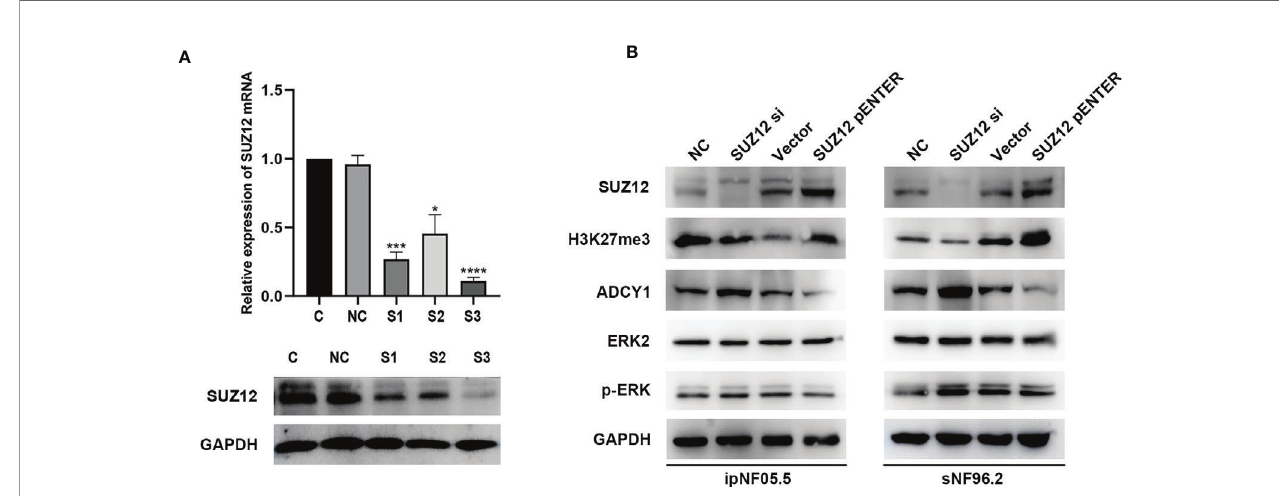
FIGURE 4 | The expression of H3K27me3, ADCY1, ERK2 and p-ERK after SUZ12 was knocked down or upregulated. (A) Western blotting and RT-PCR showing that among the three siRNA sequences transfected, S3 was the most ef fi cient (the statistical method was a t-test on the △△ CT values, *P < 0.05, ***P < 0.001 and ****P < 0.0001). (B) Western blot showing SUZ12, H3K27me3, ADCY1, ERK2 and p-ERK levels in SUZ12 transfected interfering RNA (SUZ12 si) and plasmid groups (SUZ12 pENTER) in both ipNF05.5 and sNF96.2, and NC and vector as negative control respectively.